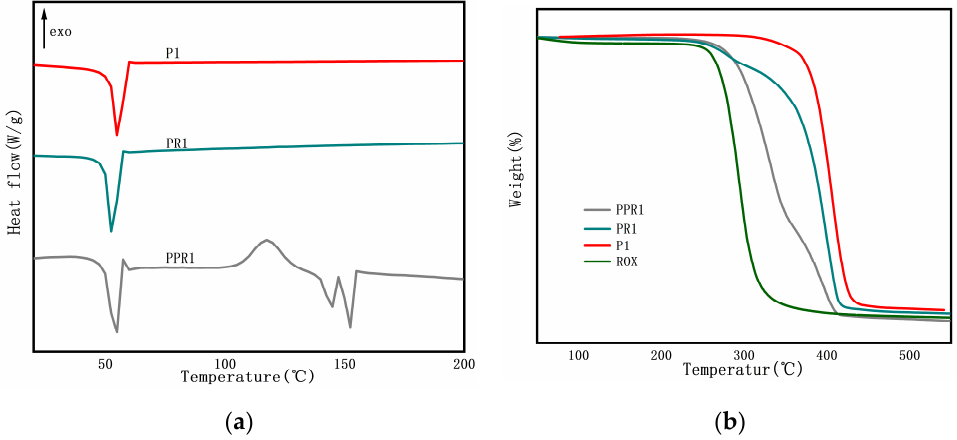
Figure 5. ( a ) DSC curve and ( b ) TGA curve of nanofibers PPR1, PR1, P1 and ROX.